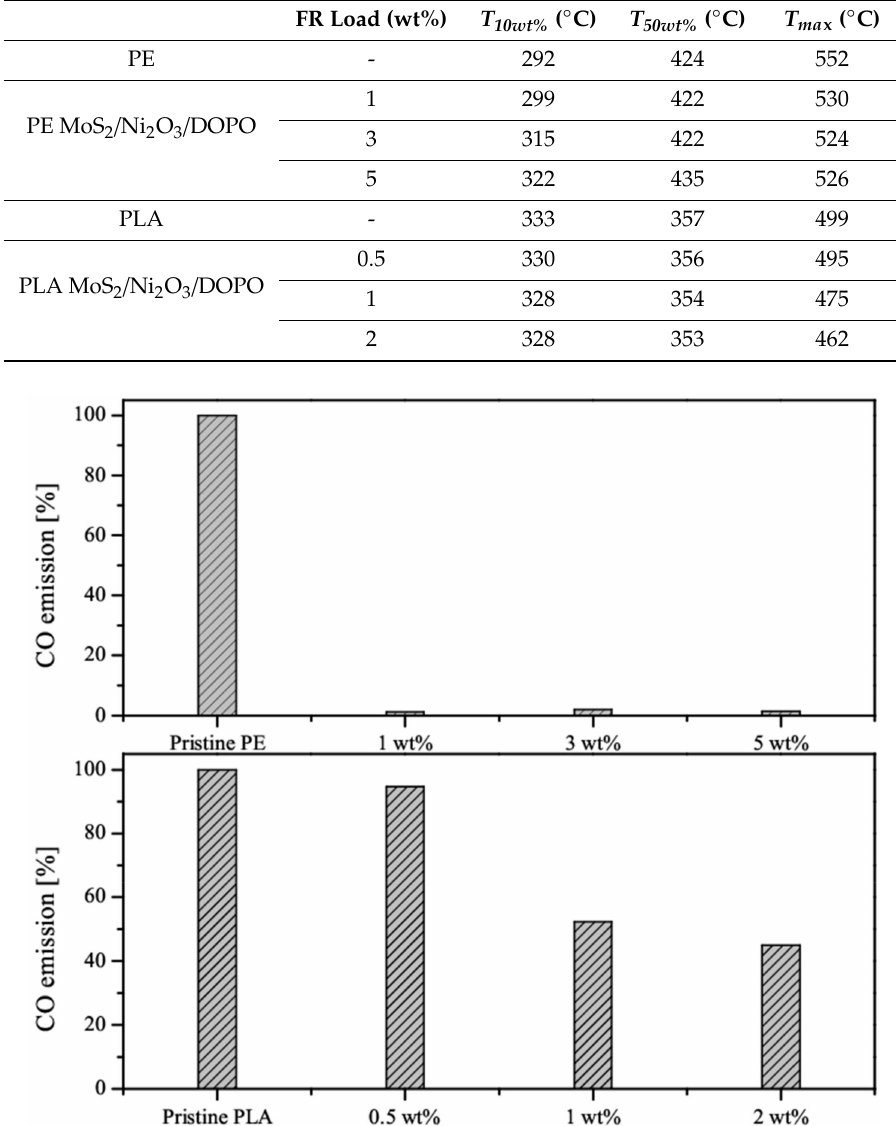
Figure 6. CO emissions of PE and PLA composites compared to pristine